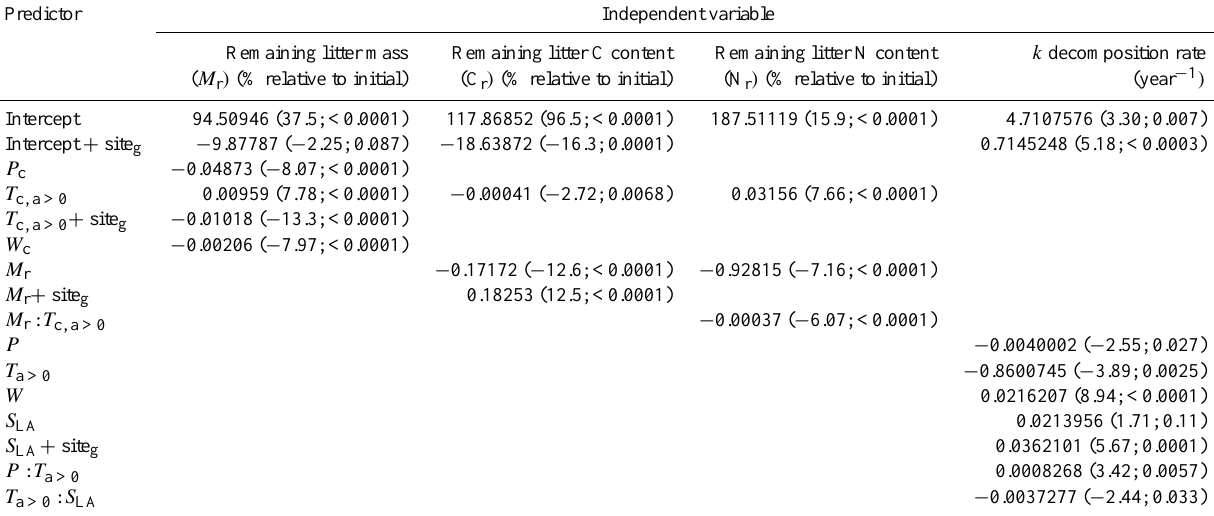
Table 2. Individual estimates (with t value and P values) of the parameters modelled in Eqs. (2) to (8). The predictors which contain “site g ” apply for models corresponding to grassland sites. In these cases, the resulting value is the result of the addition of the original predictor lacking of “site g ” and the predictor containing “site g ”. P c is cumulative precipitation, T c, a > 0 is the cumulative of daily average air temperatures higher than zero degrees Celsius, W c is the cumulative daily average soil water content, P is mean annual precipitation, T a > 0 is mean annual temperature accounting for days with positive temperatures, W is mean annual soil water content, and S LA is the total specific leaf